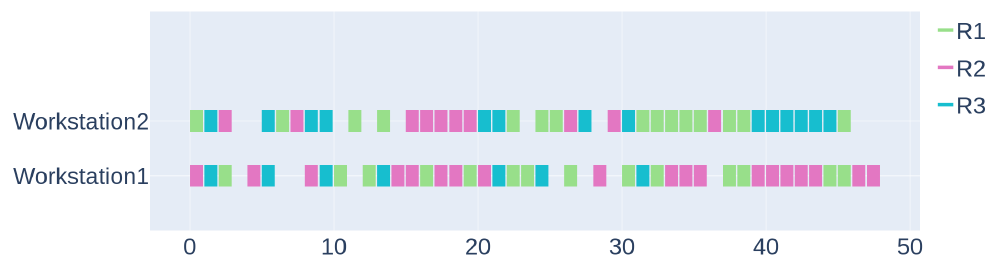
Figure 10. Scenario 2: level of resource at the workstations